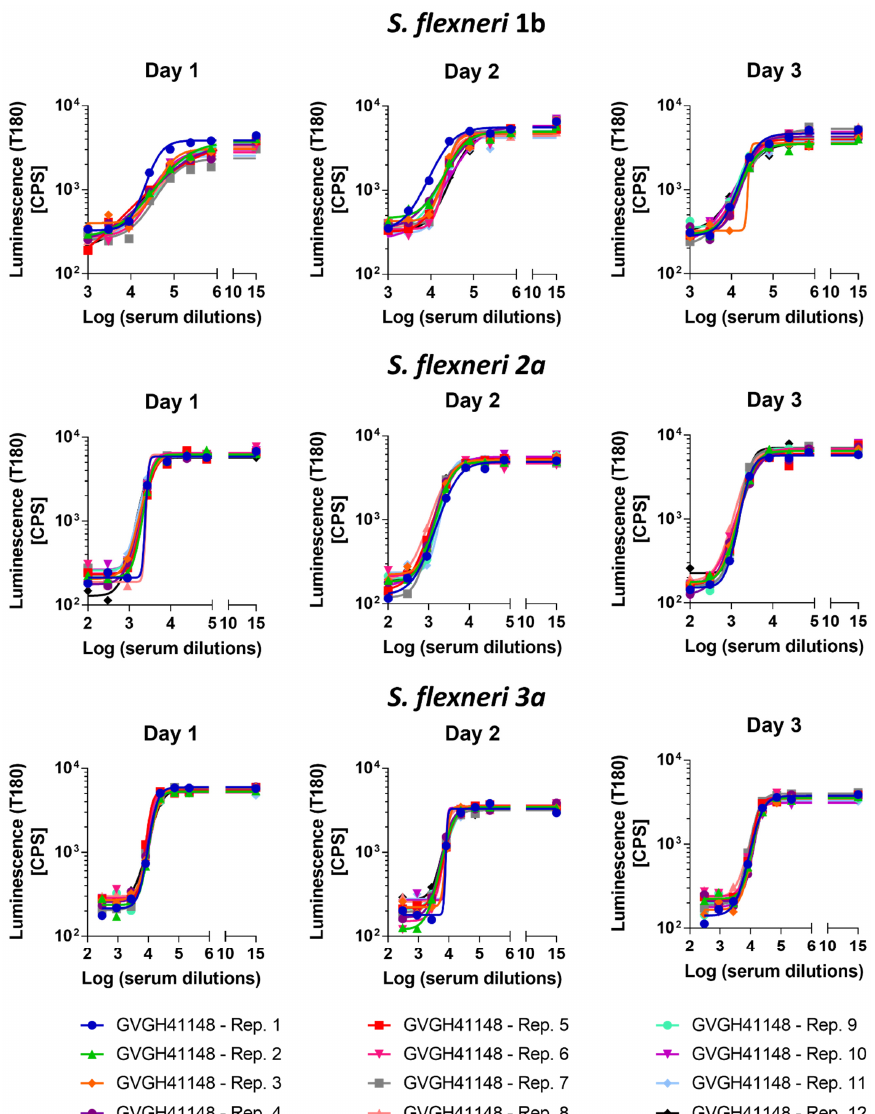
Figure 2. Luminescence vs. Log serum dilution tested to determine the precision of the assay. Symbols represent single measurements. Solid lines represent the fitted 4 parameters curves to single measurements data for each sample assayed for the three S. flexneri serotypes tested.